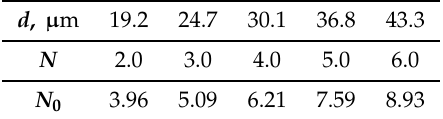
Table 1. The values of N and N 0 for the different droplet diameters d .